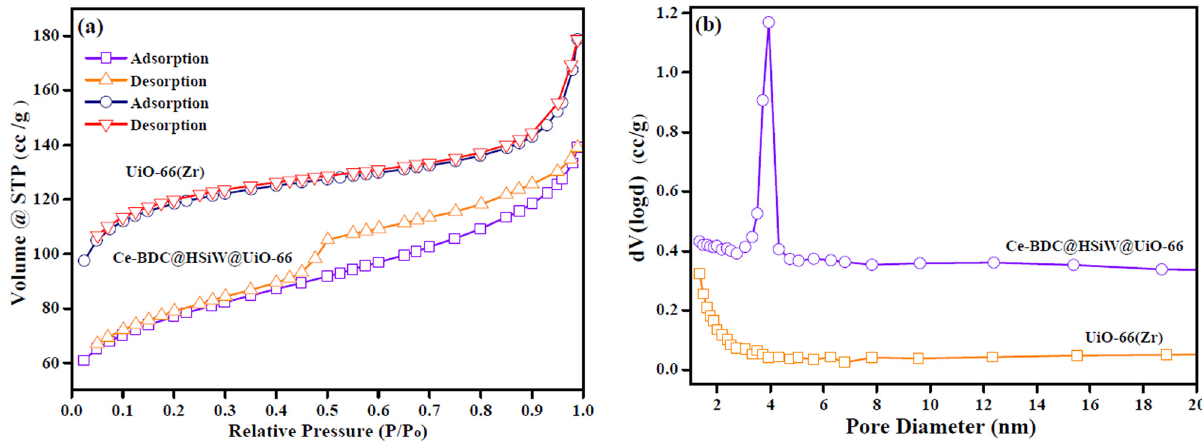
Figure 5: Nitrogen physisorption curves ( a ) and pore diameter distributions ( b ) of UiO - 66 ( Zr ) and Ce - BDC@HSiW@UiO - 66